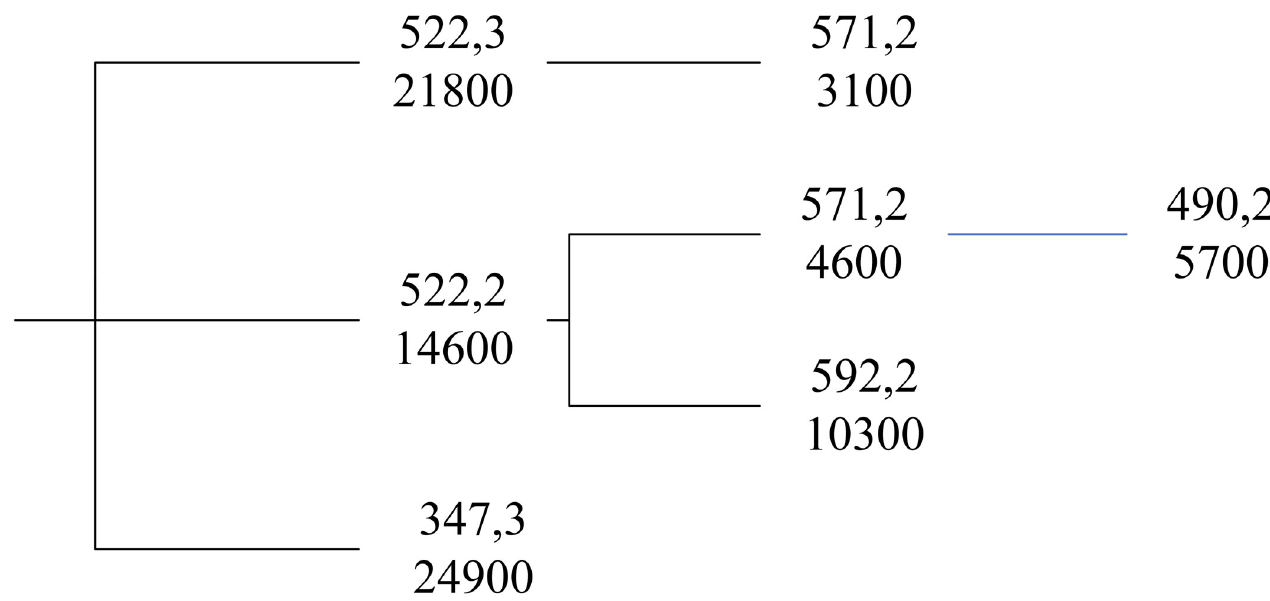
Fig 6. Trajectories formed,